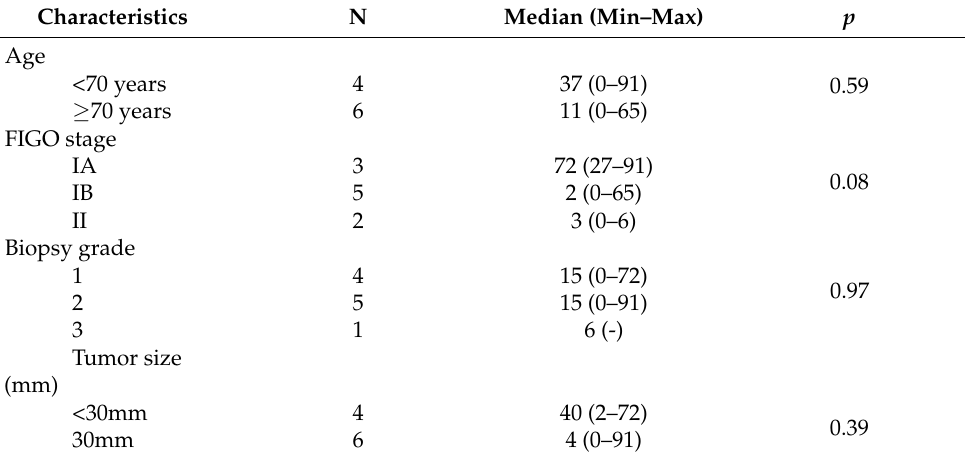
Abbreviations: FIGO, Federation of Gynecology and